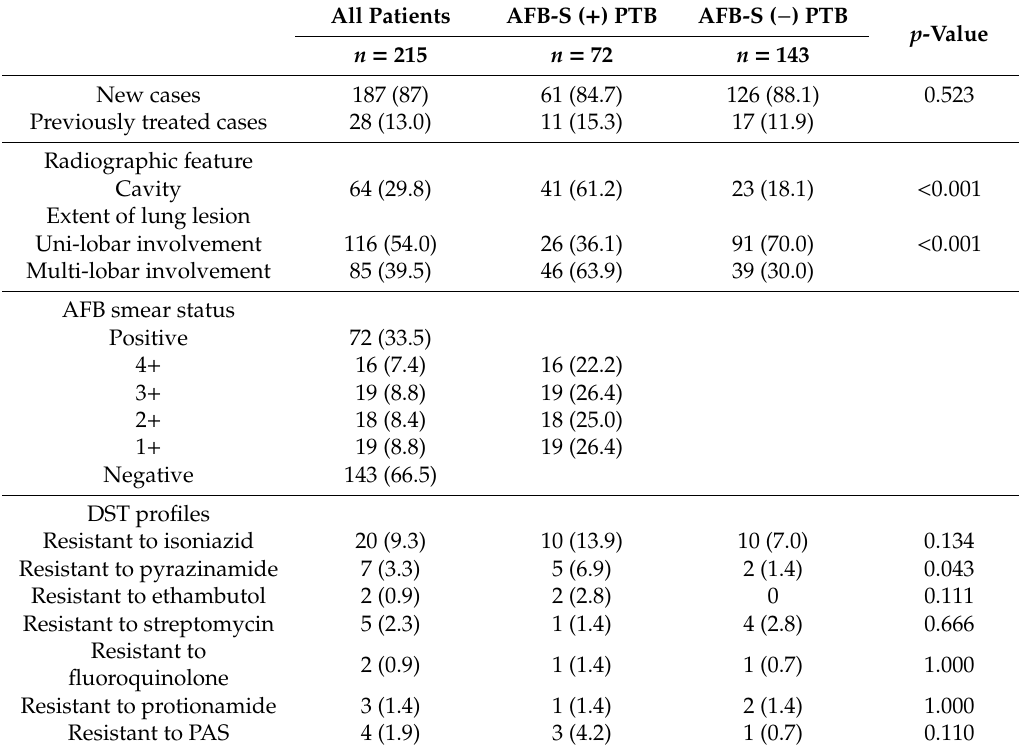
Table 2. Clinical, radiological and microbiological characteristics of the enrolled 215 cases of